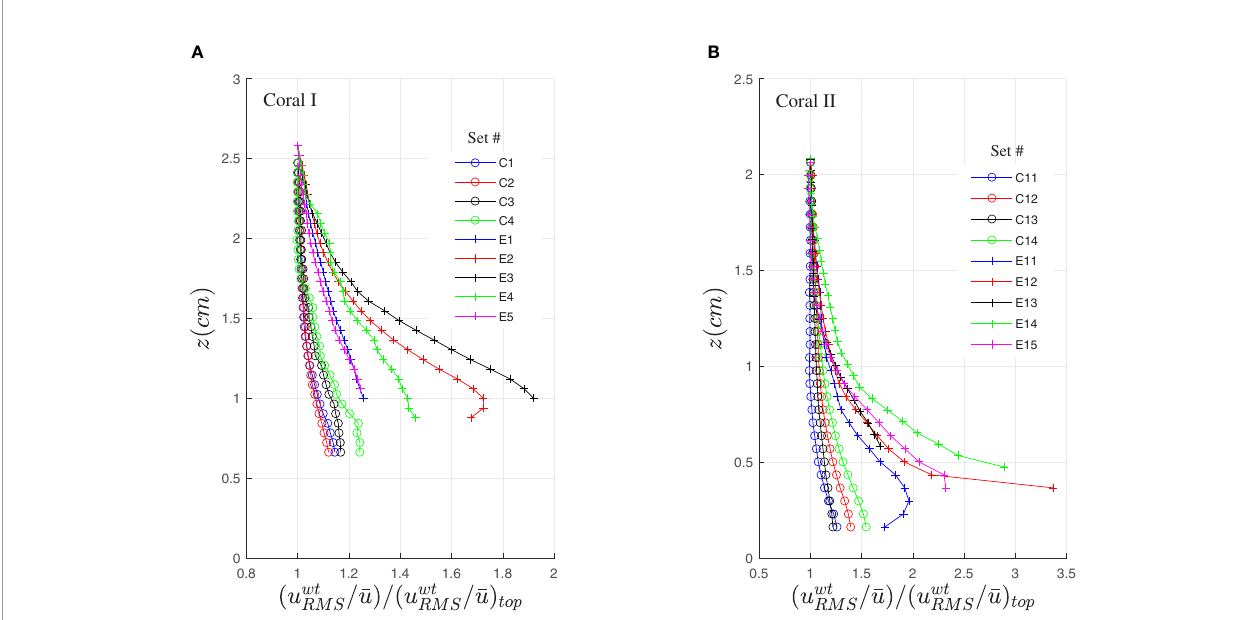
FIGURE 5 | The root mean square of the sum of the turbulent and wave velocity components, divided by the mean velocity, (cid:1) u , and normalized by the value at the top of the measured domain. The measurements were obtained when the tentacles were contracted and extended above coral I (A) and coral II (B) .